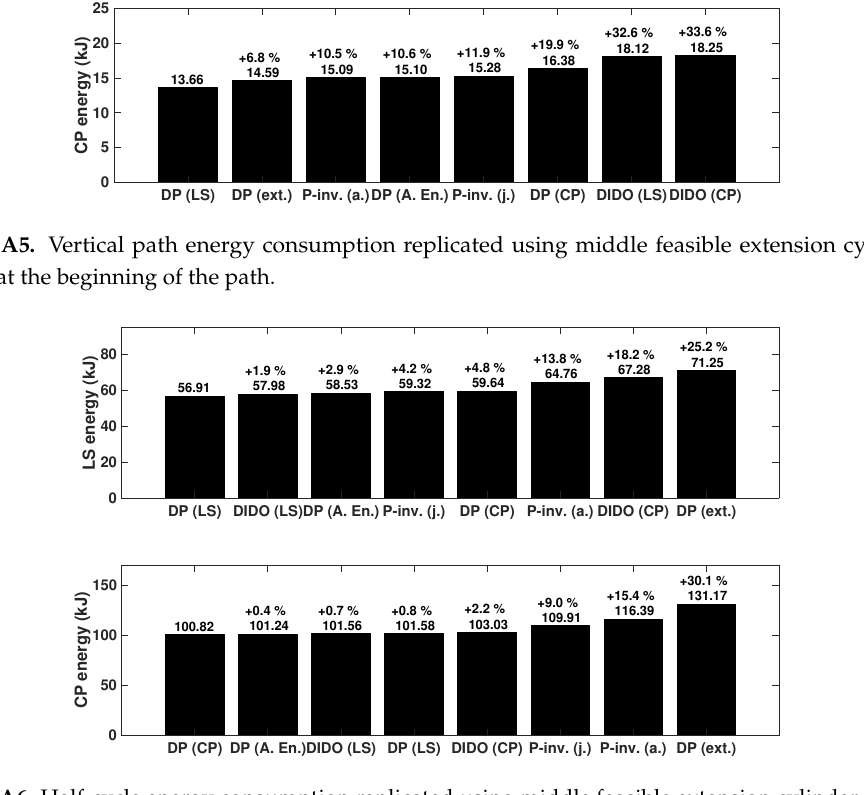
Figure A6. Half-cycle energy consumption replicated using middle feasible extension cylinder length at the beginning of the